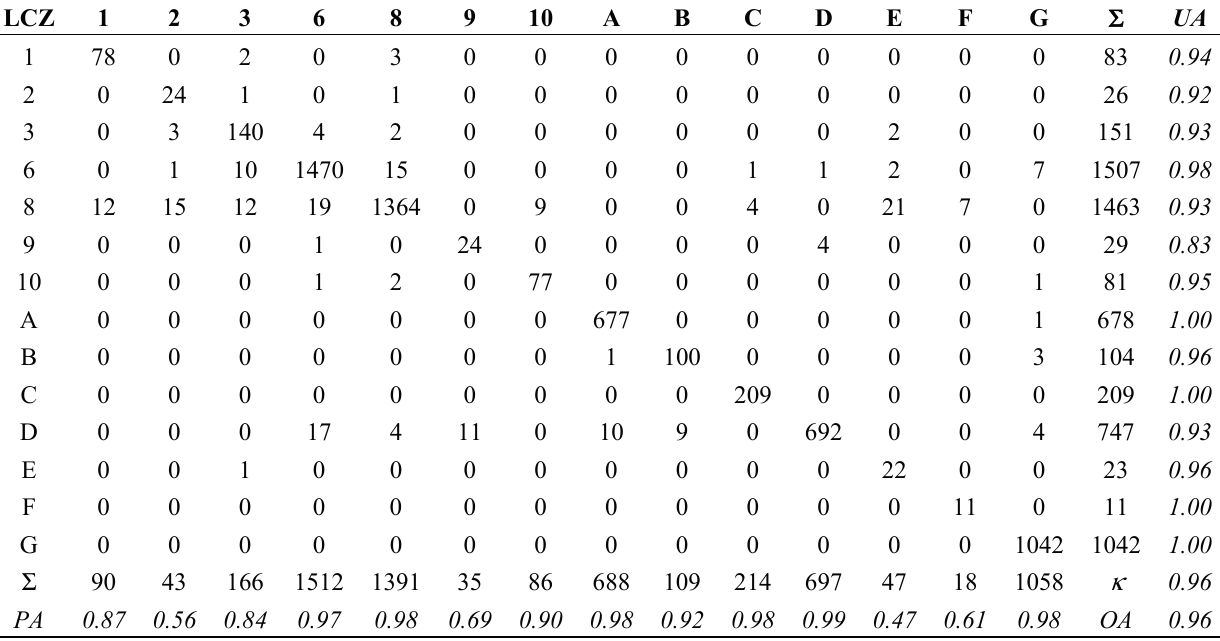
Table 3. Confusion Matrix for the classification results of Houston using 128 trees and five Landsat 8 scenes. Besides the overall accuracy (OA), the user accuracy (UA), producer accuracy (PA), and κ coefficient are provided. Evaluation is based on training data only. Rows refer to classification output, columns to reference